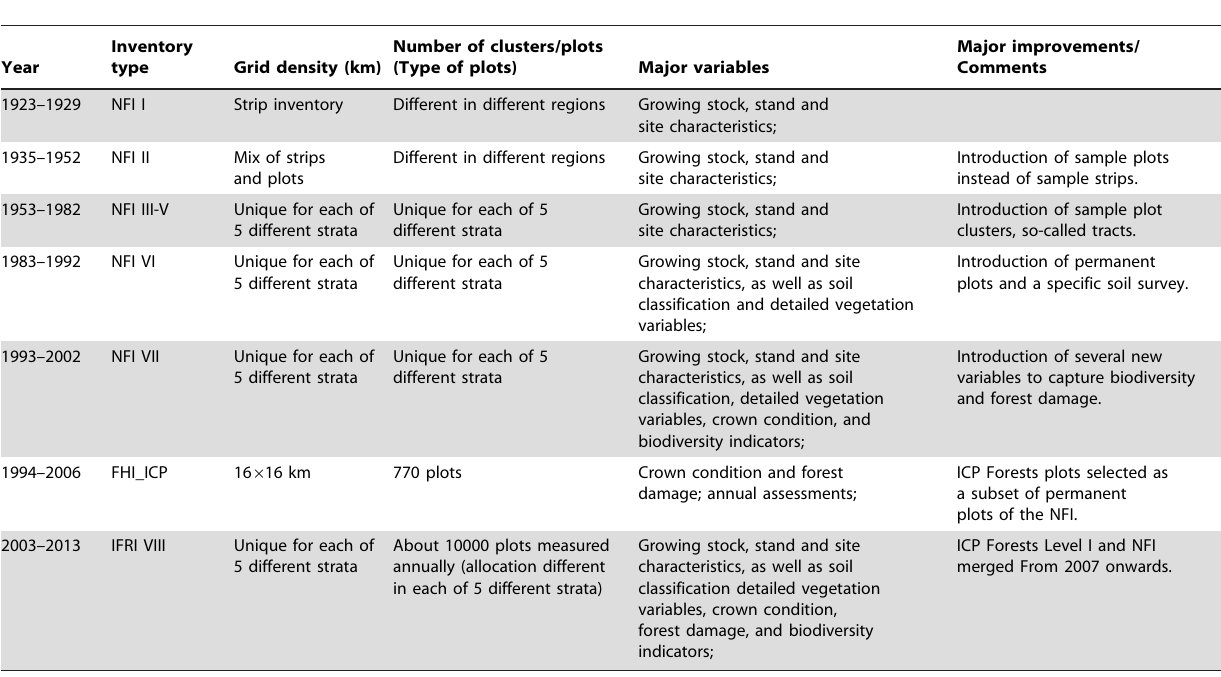
Table 4. Historical development of large-scale forest resource inventory in